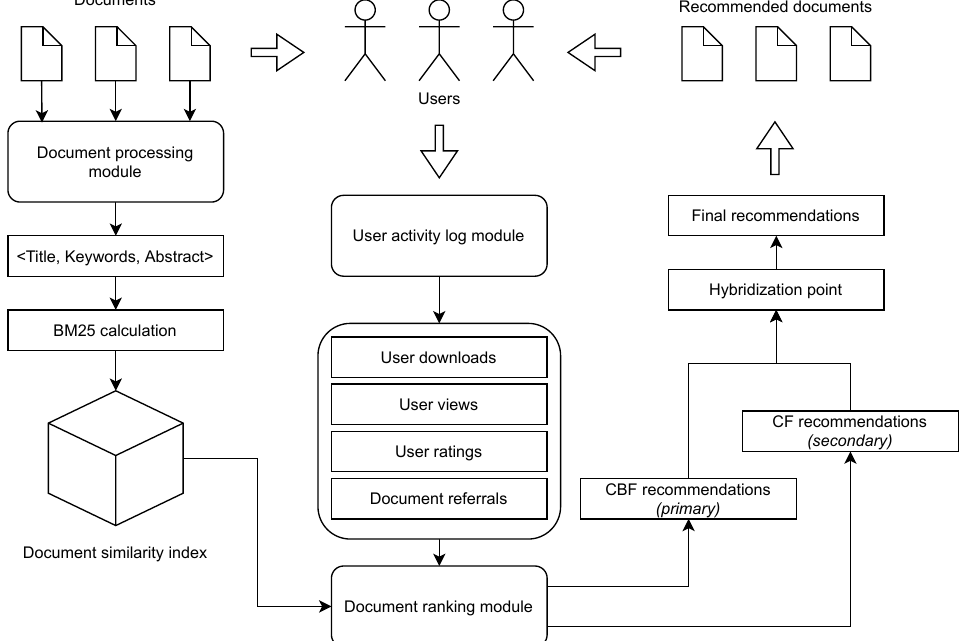
Figure 2. The architecture of our hybrid recommender